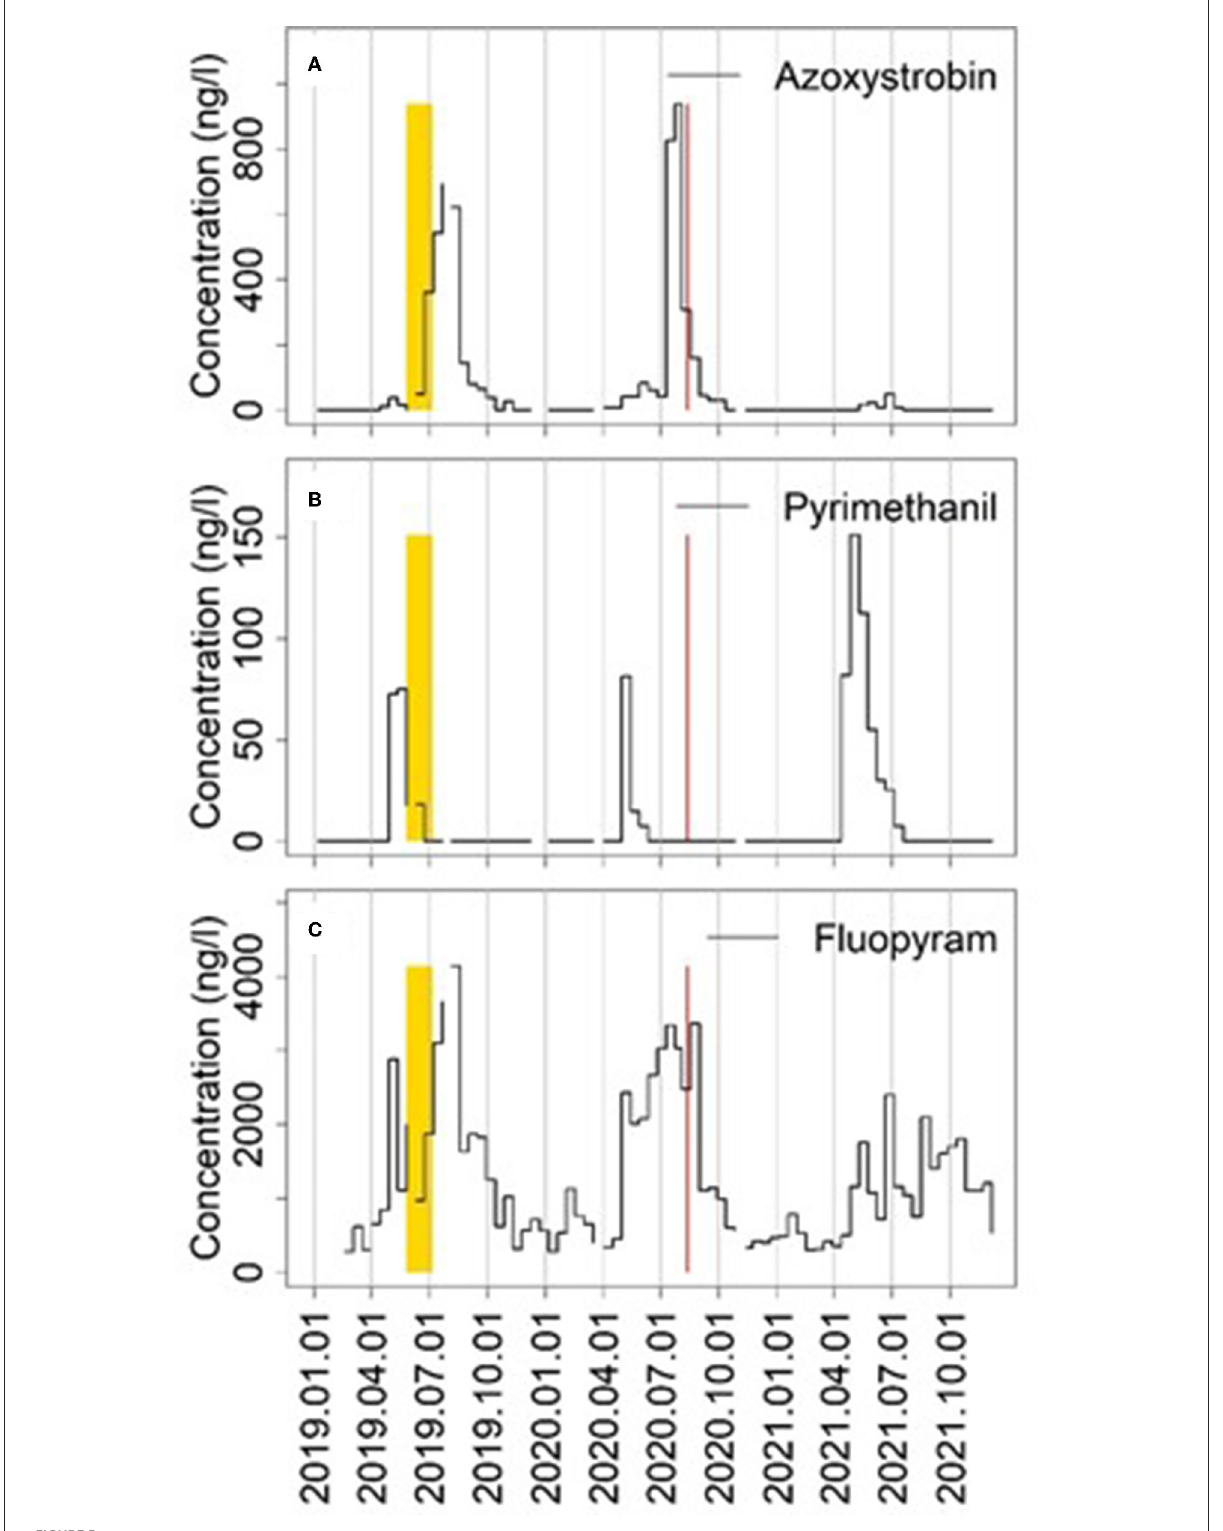
FIGURE5 Time series of the concentrations of selected PPPs measured by NAWA-Trend at 14 days resolution. The continuous low-frequency monitoring allowed for understanding the seasonal patterns of target PPPs. The yellow background highlighted the relatively short time-window covered by the high-frequency monitoring campaign with MS 2 Field in 2019. The red background visualized the period of the dry-day sampling campaign of August 12 th , 2020 (thickness cover 3 days rather than 1 day for visualization purposes). (A) Fungicide azoxystrobin, (B) fungicide pyrimethanil, and (C) fungicide